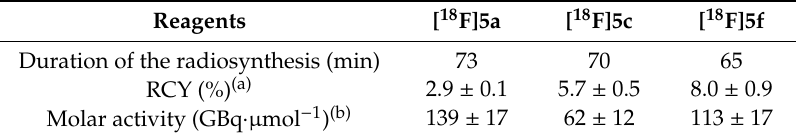
Table 3. Radiochemical yields and molar activities of the reagents [ 18 F]5a , [ 18 F]5c , and [ 18 F]5f